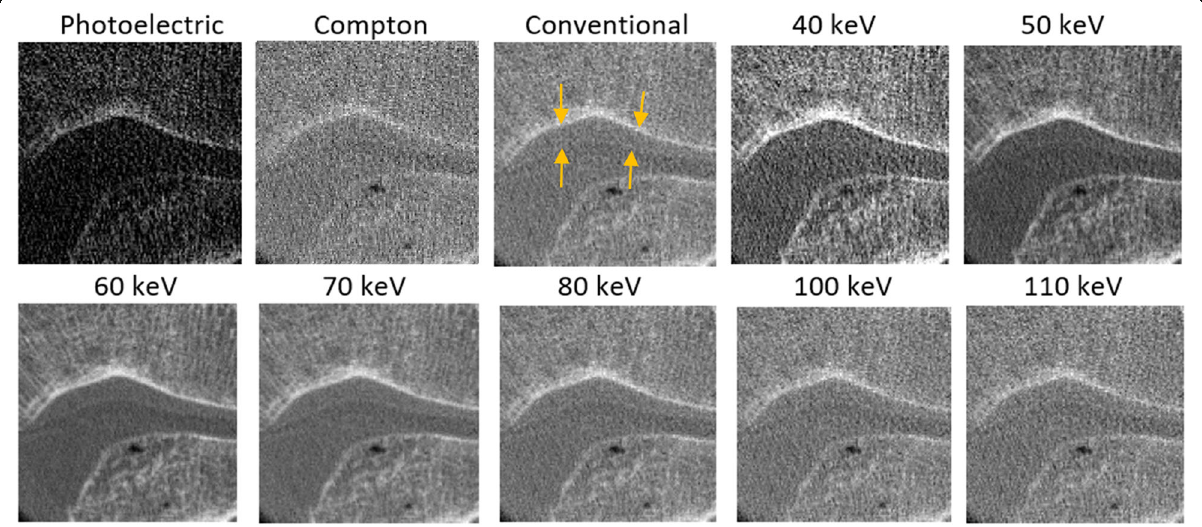
Fig. 1 Details of the reconstructed images for the decomposed materials (photoelectric and Compton effects), conventional image (merging all energy bins), and virtual monoenergetic images (as indicated) for one normal specimen. Orange arrows, upper and lower surfaces of cartilage